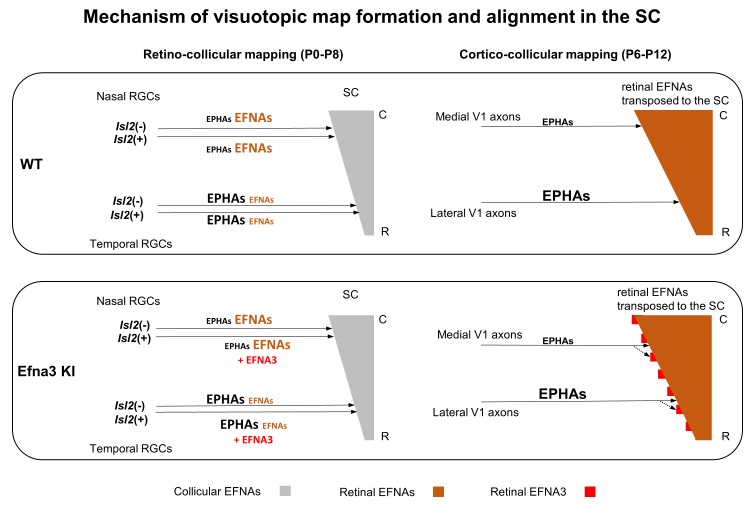
Schematic representation of the map alignment mechanism.RGCs axons in WT and Efna3 KI animals project to the SC during the first postnatal week and form the retino-collicular map through forward signaling activated by collicular EFNAs and fiber-fiber interactions (left side). In both WT and Efna3 KI animals, the retino-collicular map is single and coherent. In WT and Efna3 KI, each RGCs axon is loaded with a different concentration of retinal EFNAs (high-nasal, low-temporal) carried to the SC. Due to the coherence of the retino-collicular map, a smooth retinal EFNAs gradient is formed in the SC in WT, whereas in Efna3 KI animals, Isl2(+) RGC axons carry extra EFNA3 (in red) which creates an oscillatory retinal EFNAs gradient once transposed in the SC (right side). During cortico-collicular mapping, V1 axons carrying EPHA receptors are facing a smooth gradient of retinal EFNAs in the SC, leading to a single coherent map in WT. In Efna3 KI animals, V1 axons carrying EPHA receptors are facing an oscillatory gradient of retinal EFNAs (due to ectopic expression of EFNA3 in Isl2(+) RGCs) which leads to the duplication of the cortico-collicular map (43% in Efna3KI/+ and 47% in Efna3KI/KI) through local neighbor–neighbor relationships of V1/RGCs TZs via repulsion. C, caudal; R, rostral; WT, wild-type; TZ, termination zone; RGCs, retinal ganglion cells.